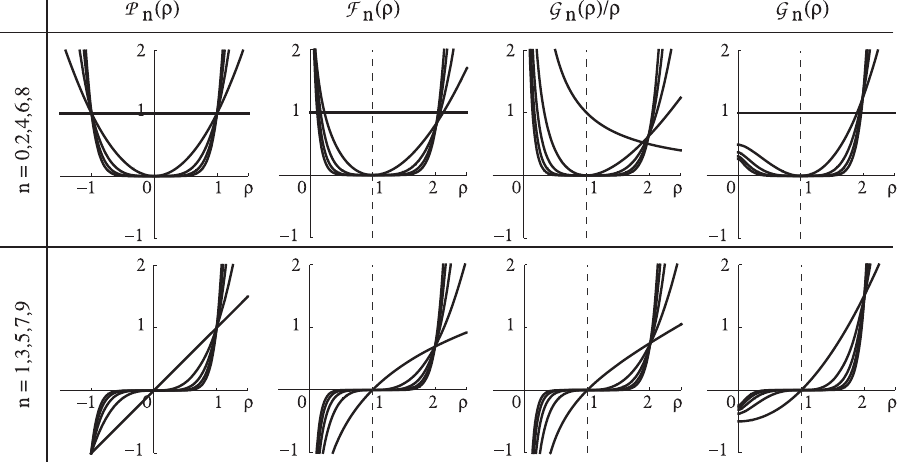
and G n ð ρ Þ functions ρ